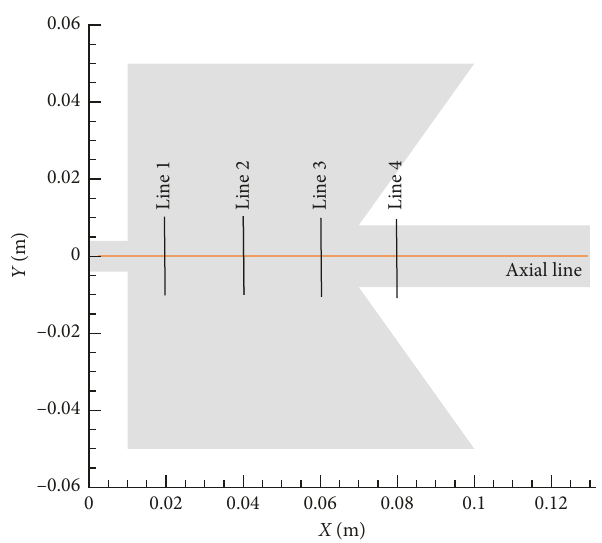
Figure 4: Distribution of monitoring